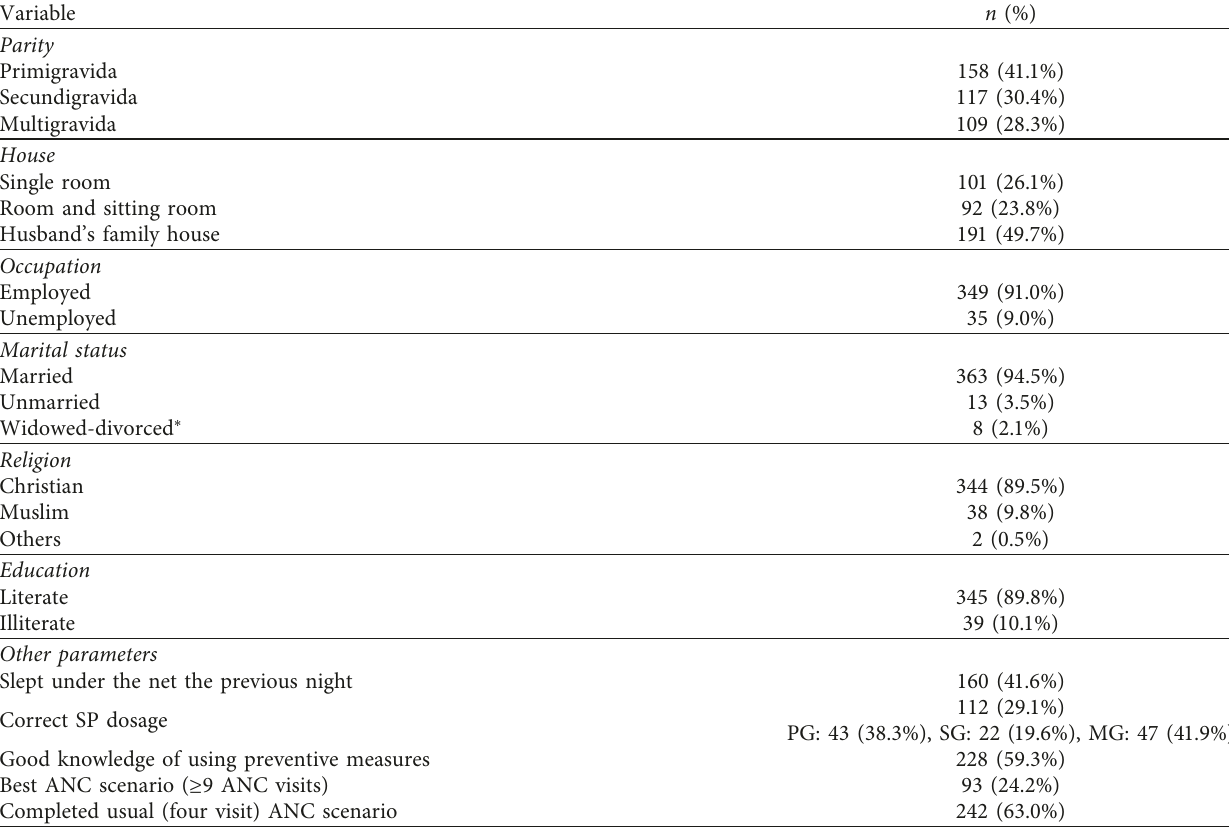
Table 2: Sociodemographic characteristics of participants in Nnewi,